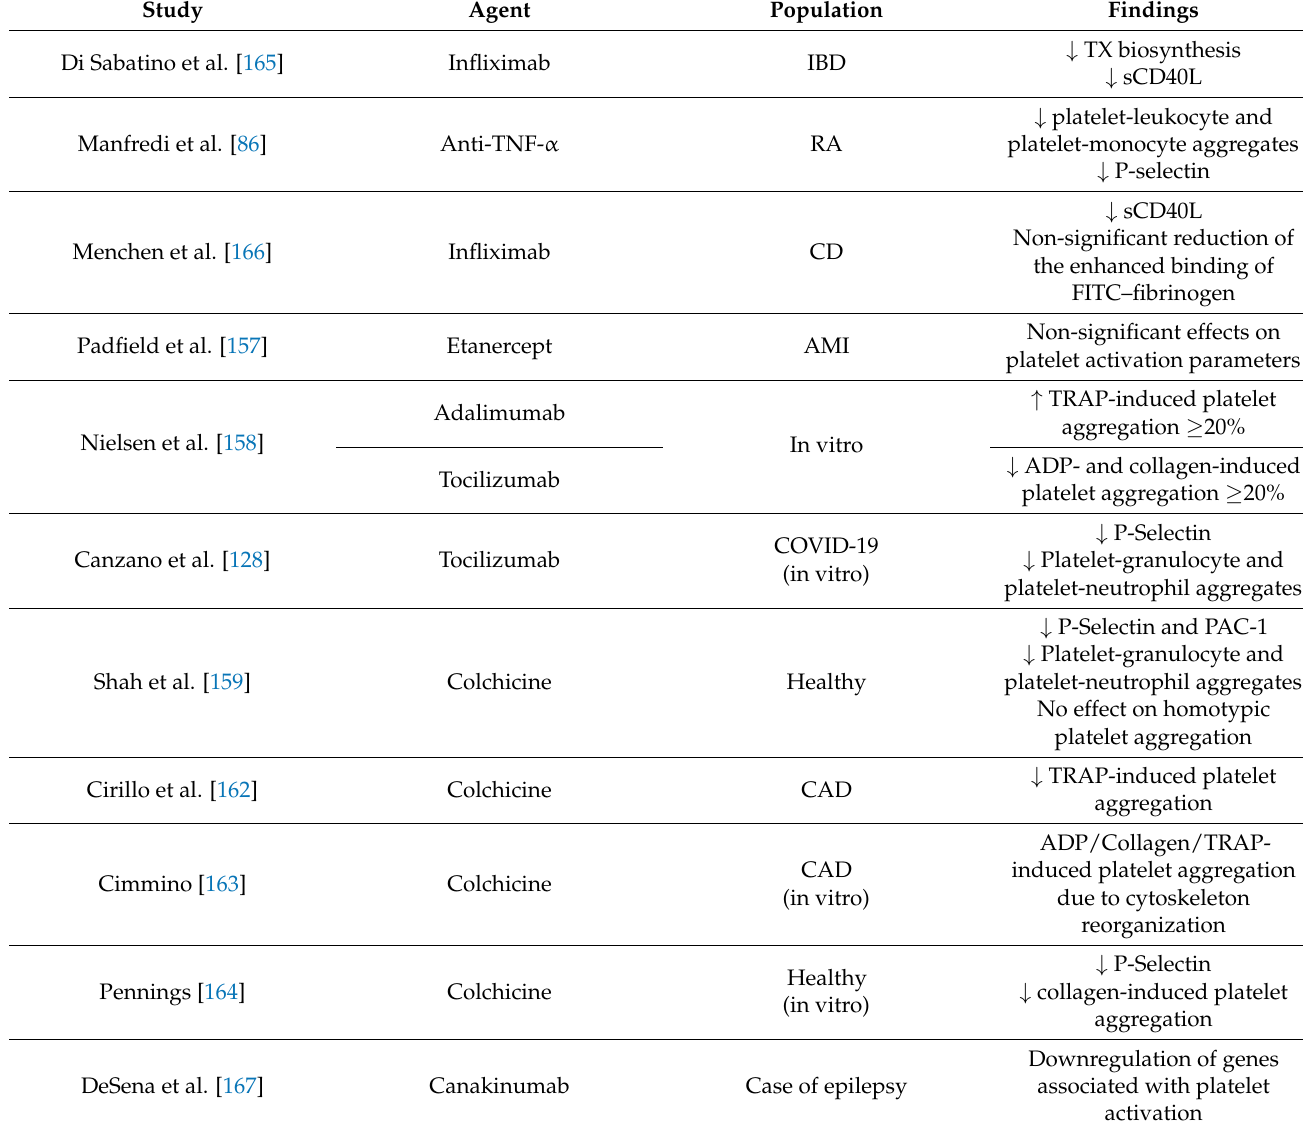
Table 1. Studies evaluating the effect of the available anti-inflammatory agents on platelet activation